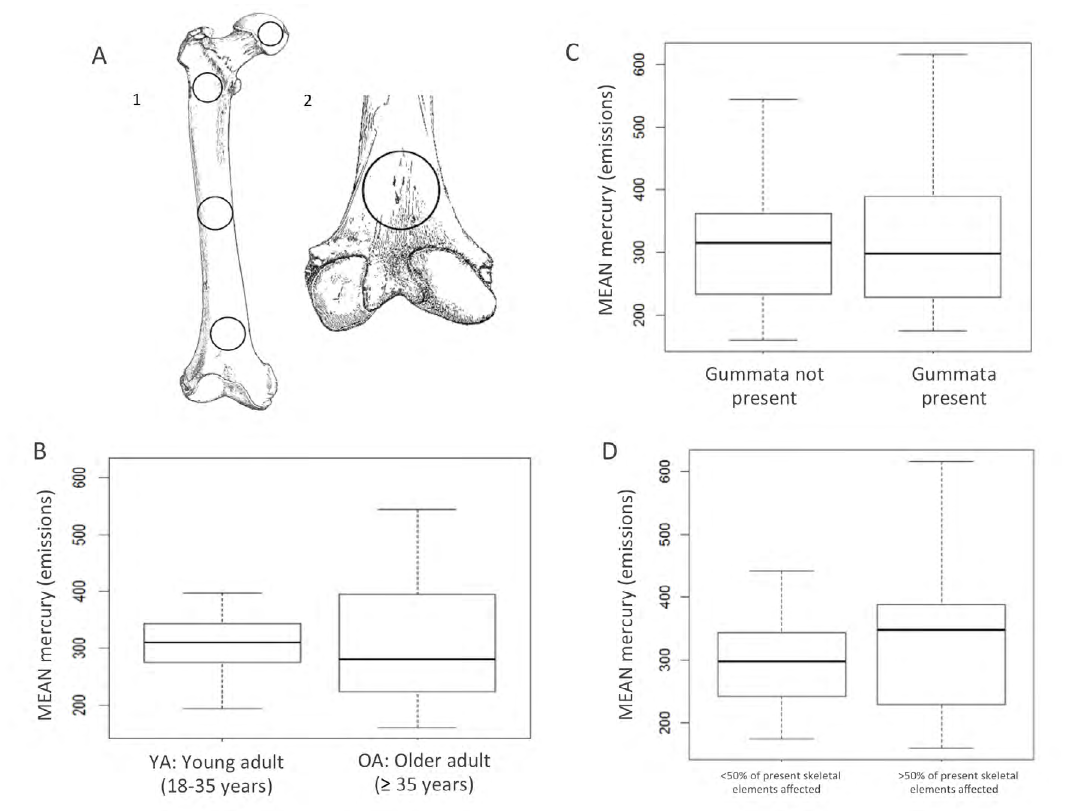
Figure 3. A. Sampling locations on the femur, 1. anterior, and 2. posterior. B. Mean mercury emissions in relation to